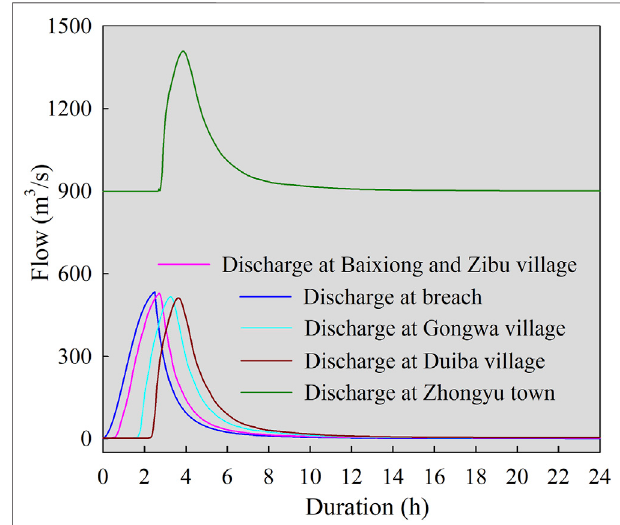
FIGURE 7 | The discharge hydrograph at different locations along fl ow